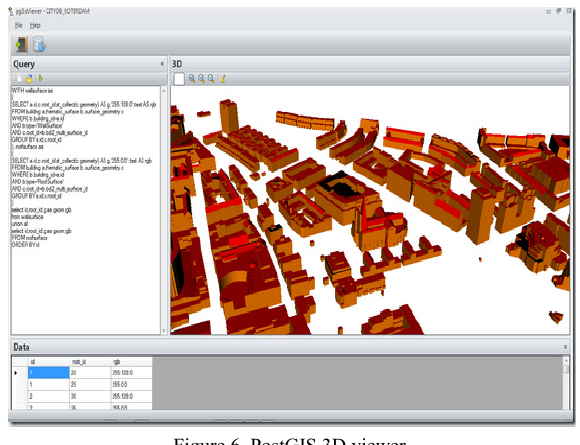
Figure 6. PostGIS 3D